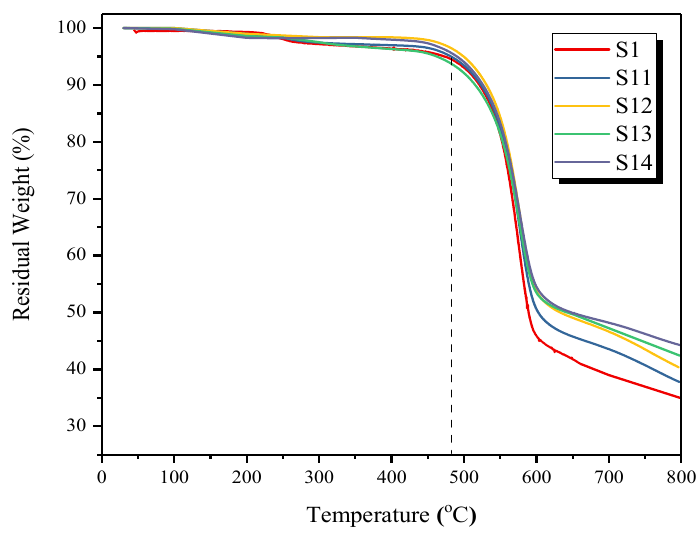
Figure 6. TGA thermograms of pure PES membrane and PES/modified silica MMMs.